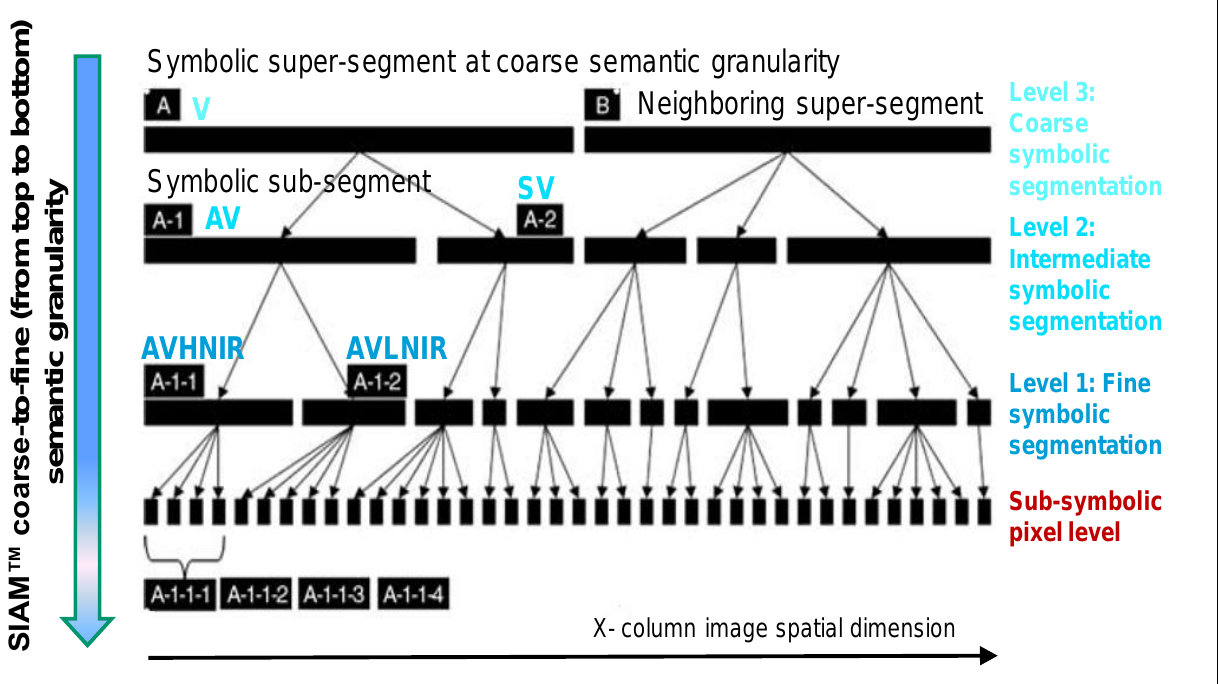
Figure 7. Adapted from K. Navulur (2007). SIAM™ implementation at three different granularity levels of classification (fine, intermediate and coarse): symbolic 2-D object- based parent-child relationships across spatial scales. Legend of the SIAM™ symbols. V: Vegetation, AV: Average Vegetation, SV: Strong Vegetation, NIR: Near Infra-Red, AVHNIR: AV with High NIR, AVLNIR: AV with Low NIR. For example, starting from the fine granularity classification level, the OR-combination of the “children” spectral categories AVLNIR, AV with Medium NIR (AVMNIR) (not shown) and AVHNIR generates the “parent” spectral category AV at the intermediate semantic granularity level. Starting from the intermediate granularity classification level, the OR-combination of the “children” spectral categories SV, AV and Dark Vegetation (DV) (not shown) generates the “parent” spectral category V at the coarse semantic granularity level, etc . It is noteworthy that the SIAM™ symbolic 2-D object-based parent-child multi-scale relationships are detected automatically and provided with semantic labels, unlike the parent-child relationships detected by traditional semi-automatic sub-symbolic multi-scale image segmentation algorithms (e.g., Definien’s). In practice, SIAM™ accomplishes image sub-symbolic segmentation and image symbolic pre-classification simultaneously (refer to Section 3).